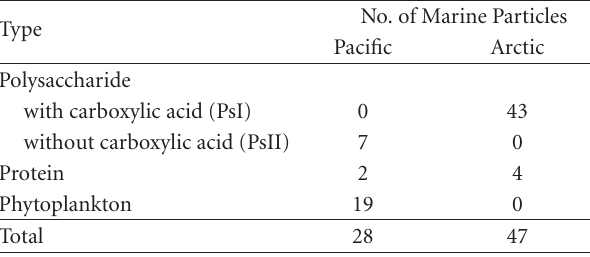
Table 1: X-ray spectra carbon K-edge, near-edge, and postedge features.